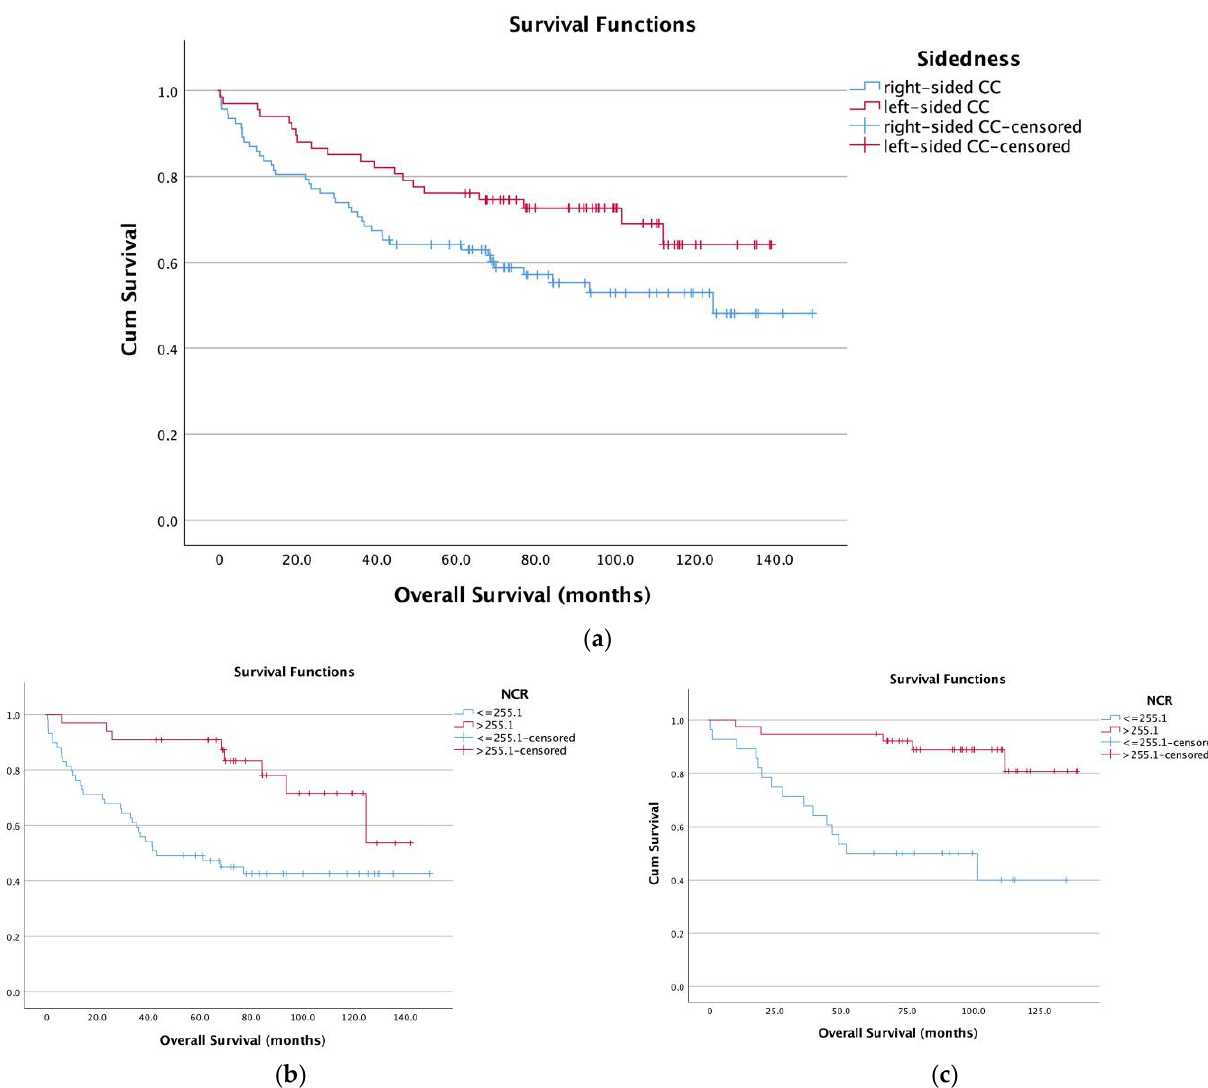
Figure 5. Kaplan – Meier curves for OS based on sidedness: right-sided and left-sided CC ( a ); Kaplan – Meier curves for OS based on NCR for right-sided colon cancer patients ( b ) and Kaplan – Meier curves for OS based on NCR for left-sided colon cancer patients in the discovery cohort ( c ).